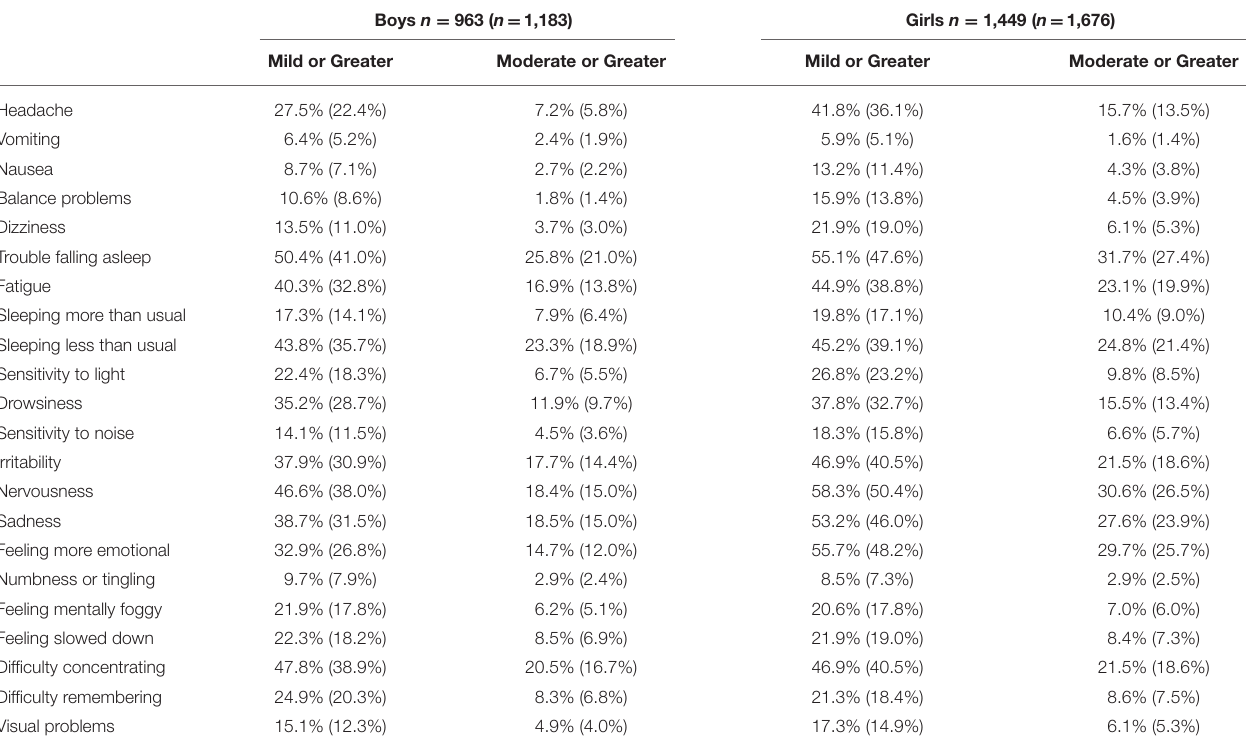
TABLE 3 | Percentage endorsing individual symptoms stratified by